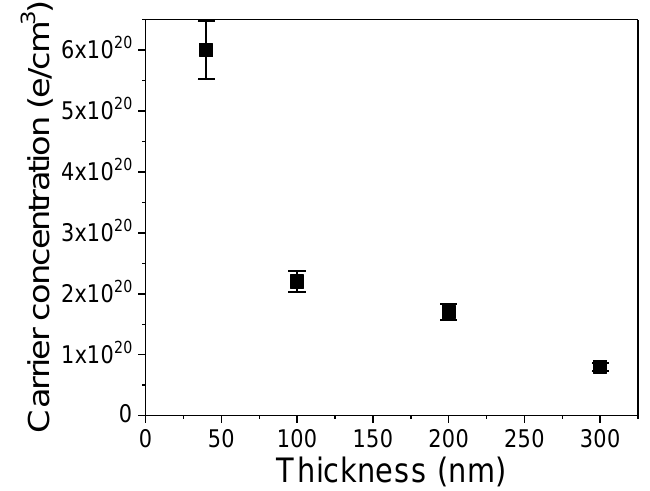
Figure 6. The maximum carrier concentration estimated from Hall effect measurements as a function of the thickness of the doped layer in P-implanted Ge after FLA for 20 ms with an energy density of 120 Jcm − 2 .